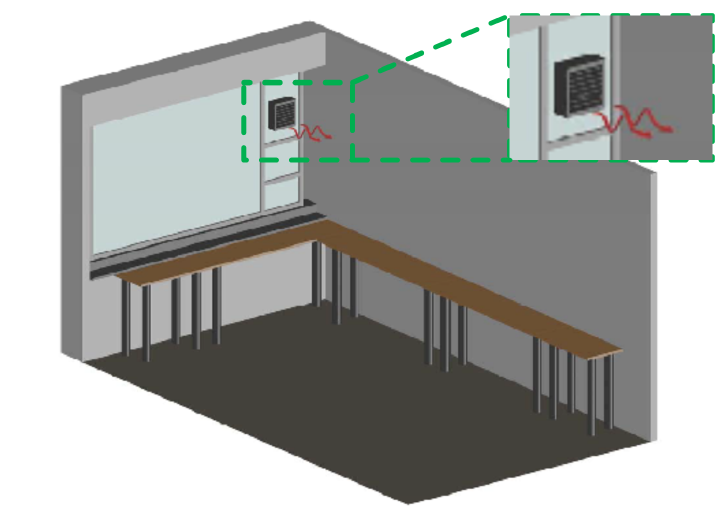
Figure 3. Measurement room with one